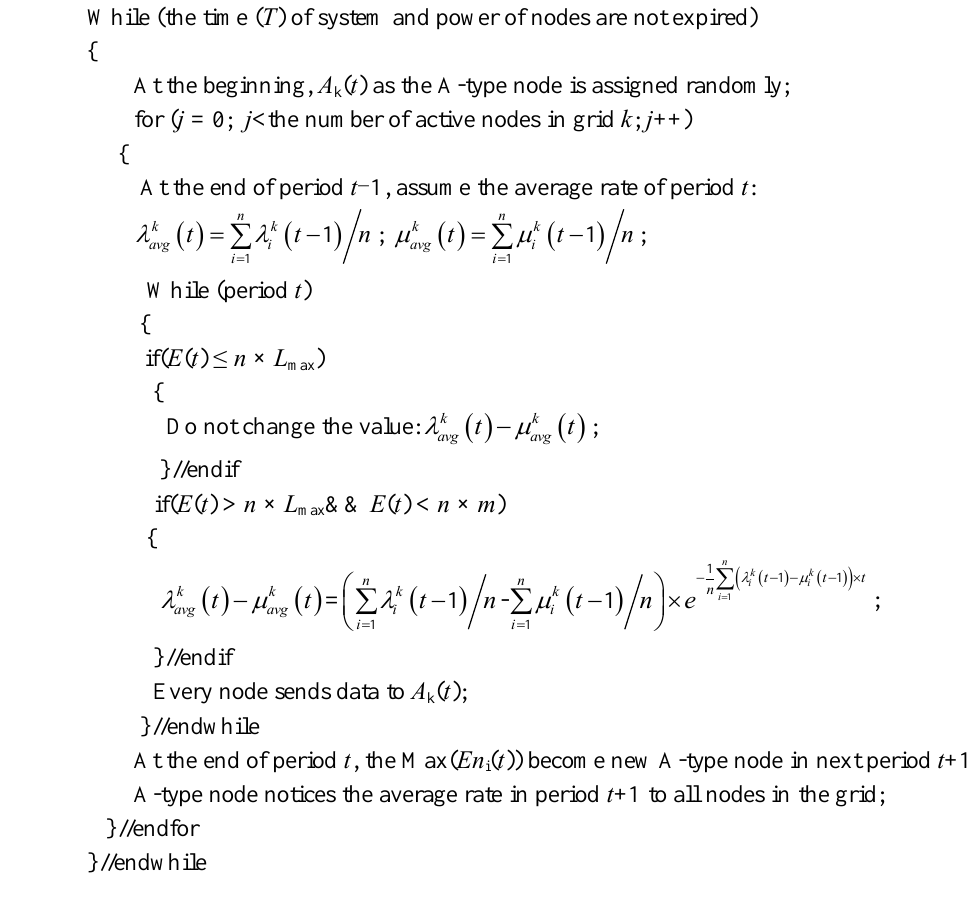
Figure 7. The pseudo-code for local network (grid) rate control